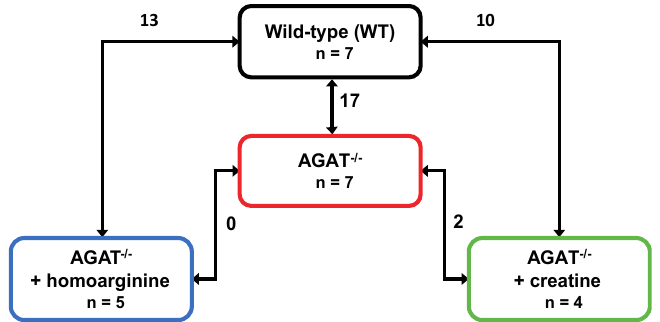
Figure 1. Number of differentially expressed genes in brains of WT, AGAT − / − , AGAT − / − hArg and AGAT − / − Cr mice. Transcriptome profiling was performed using the Affymetrix Mouse GeneChip 1.0 ST Array. Each line indicates the comparison of the respective two groups and the number of significantly regulated genes. Significance level: false discovery rate ≤ 0.05. Abbreviations: AGAT − / − , AGAT knock ‐ out; n, number of animals. Table 1. Differentially expressed genes between WT and AGAT − / − mice in brain tissue. p values and fold changes (FC) are given for the discovery cohort and the validation cohort. False discovery rate ≤ 0.05. Significantly regulated genes in both cohorts are written in bold. Abbreviations: b.d.l., below detection limit.